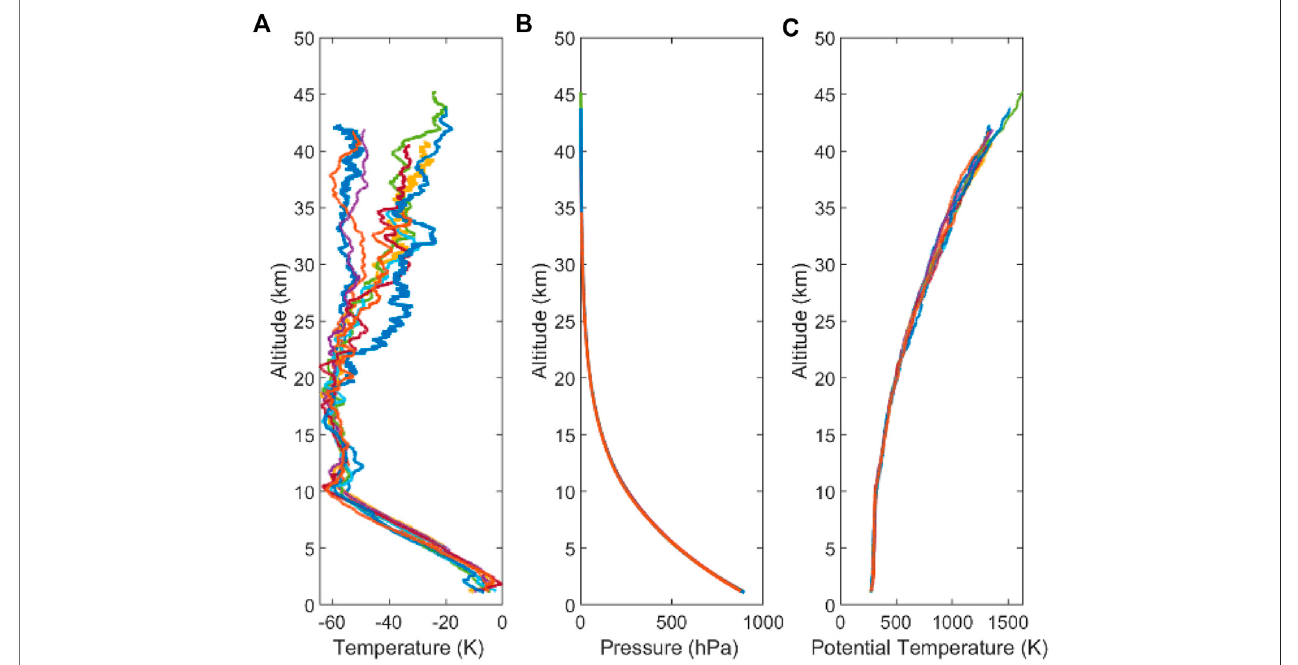
FIGURE 1 | Temperature, pressure and potential temperature distribution of 9 sets of radiosonde data. (A – C) show temperature pressure and potential temperature respectively.